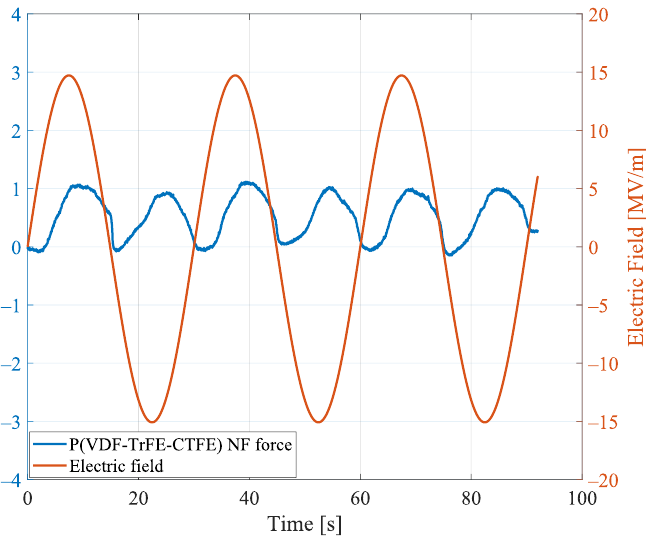
Figure 12. Contraction forces in the uniaxial load test for the P(VDF-TrFE-CTFE) nanofiber (NF) mat for a sinusoidal applied electric